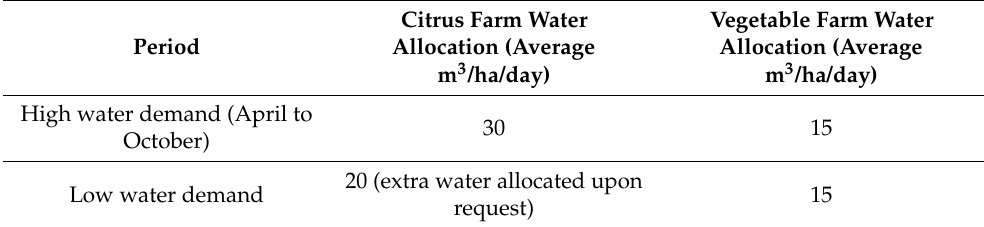
Table 3. Crop-based water quota allocations in the Northern Jordan Valley (NJV), citrus versus vegetable farms